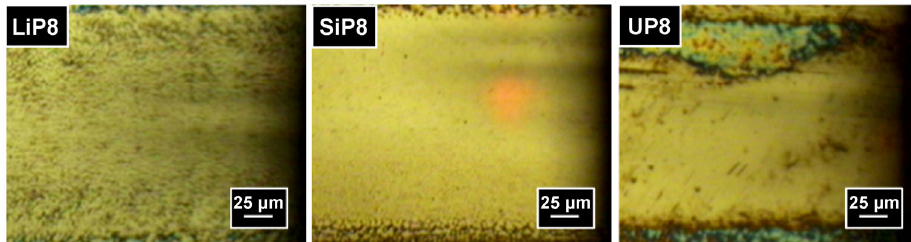
Fig. 7 Track condition after rolling for 350